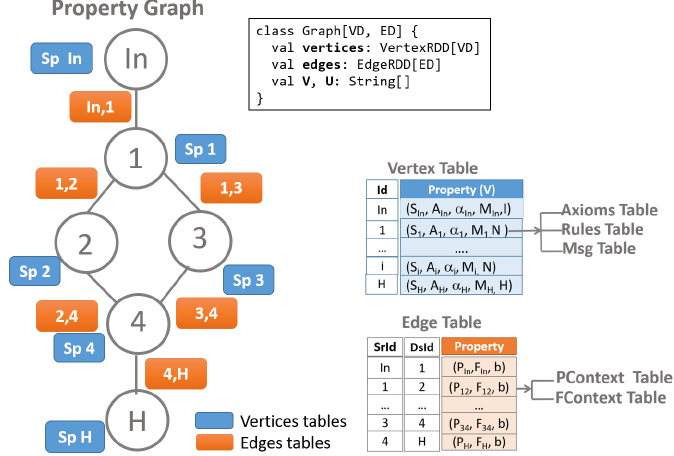
Figure 4. NSUP configuration translated into a PropertyGraph of